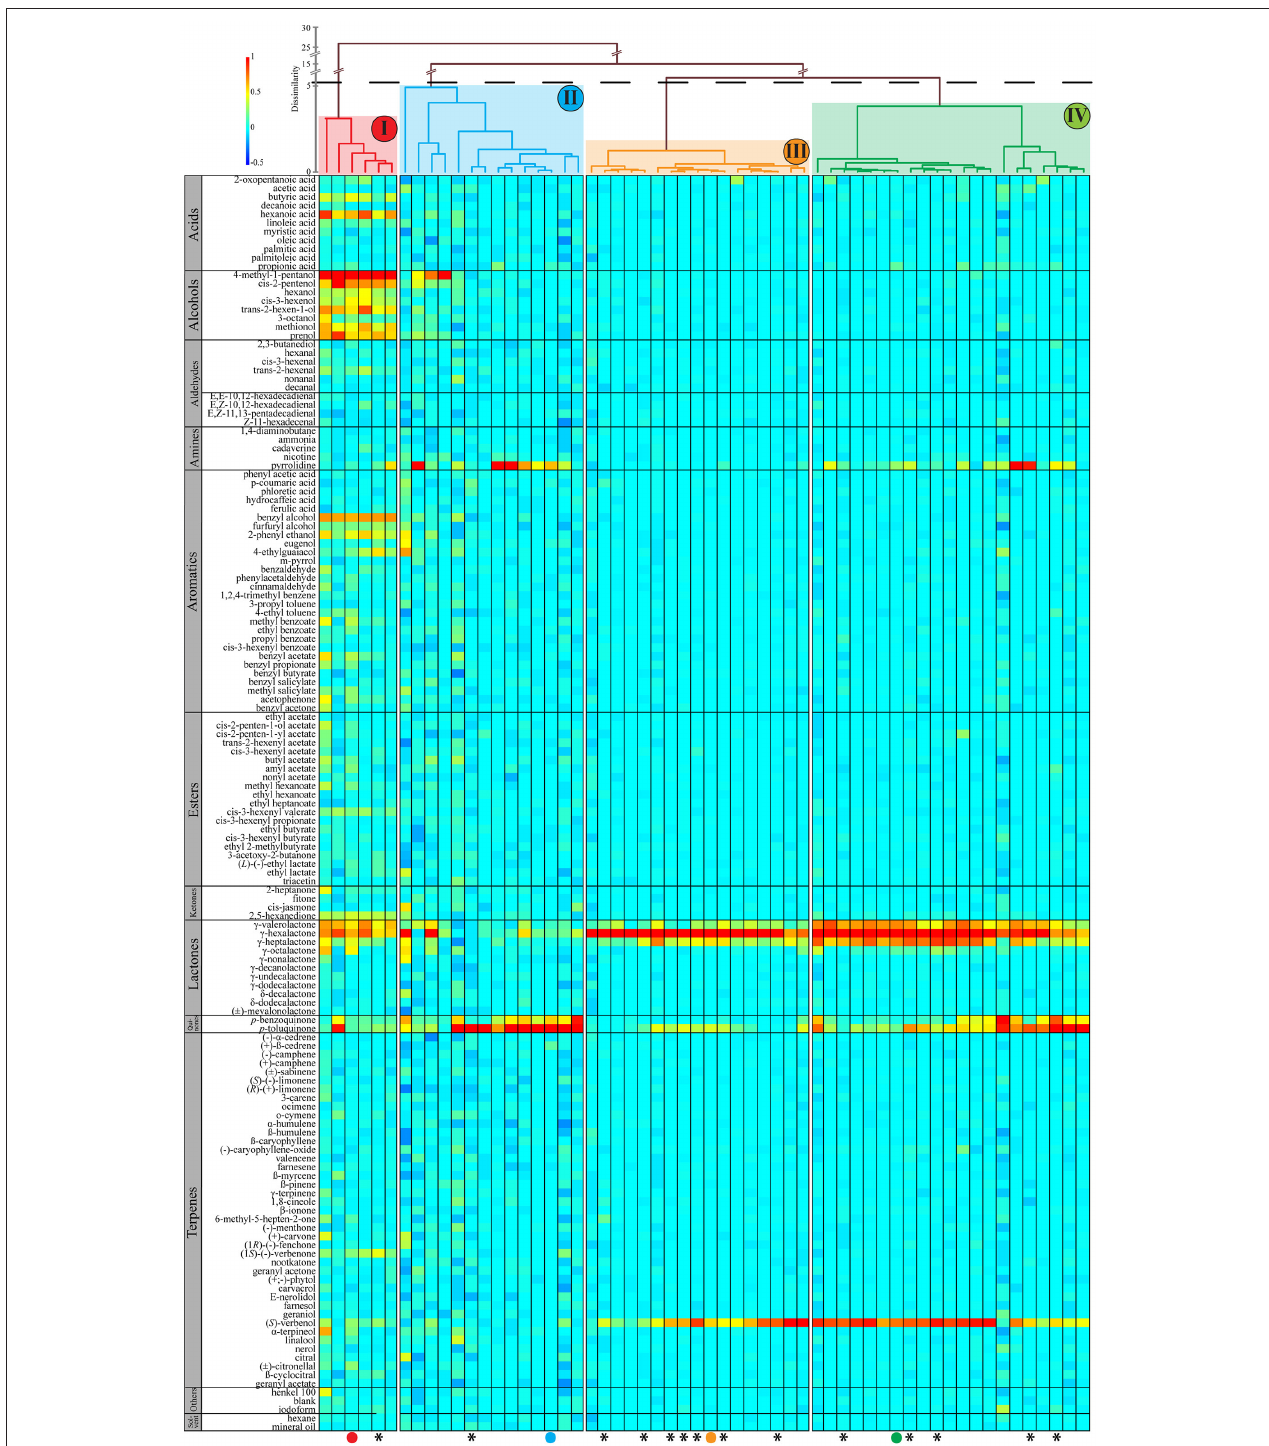
FIGURE 5 | Odorant response profiles of 58 individual OSNs (x-axis) in response to 142 individually presented odorants (y-axis) from 49 sensilla from the ovipositor of female M. sexta moths. Classification dendrogram was generated using wards agglomerative hierarchical clustering method. The dotted line represents the automatic truncation, leading to four functional neuron classes (I–IV). Responses are normalized and color coded for each neuron: red indicates the maximum response by the given OSN across all odorants; yellow, medium excitation (50%); light green, weak excitation (25%); light blue, no response and dark blue indicates that spontaneous spiking activity was reduced compared to baseline. All odorants were diluted to a final concentration of 10 µ g/ µ l either in hexane or mineral oil. Asterisks symbolize mated females. The colored dots refer to Figure 6 where SSR traces of these OSNs are shown to represent each of the four functional OSN